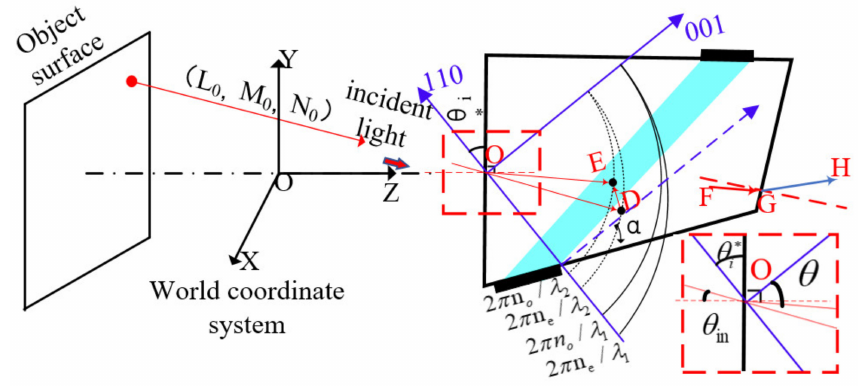
Figure 2. Ray tracing of AOTF in three-dimensional